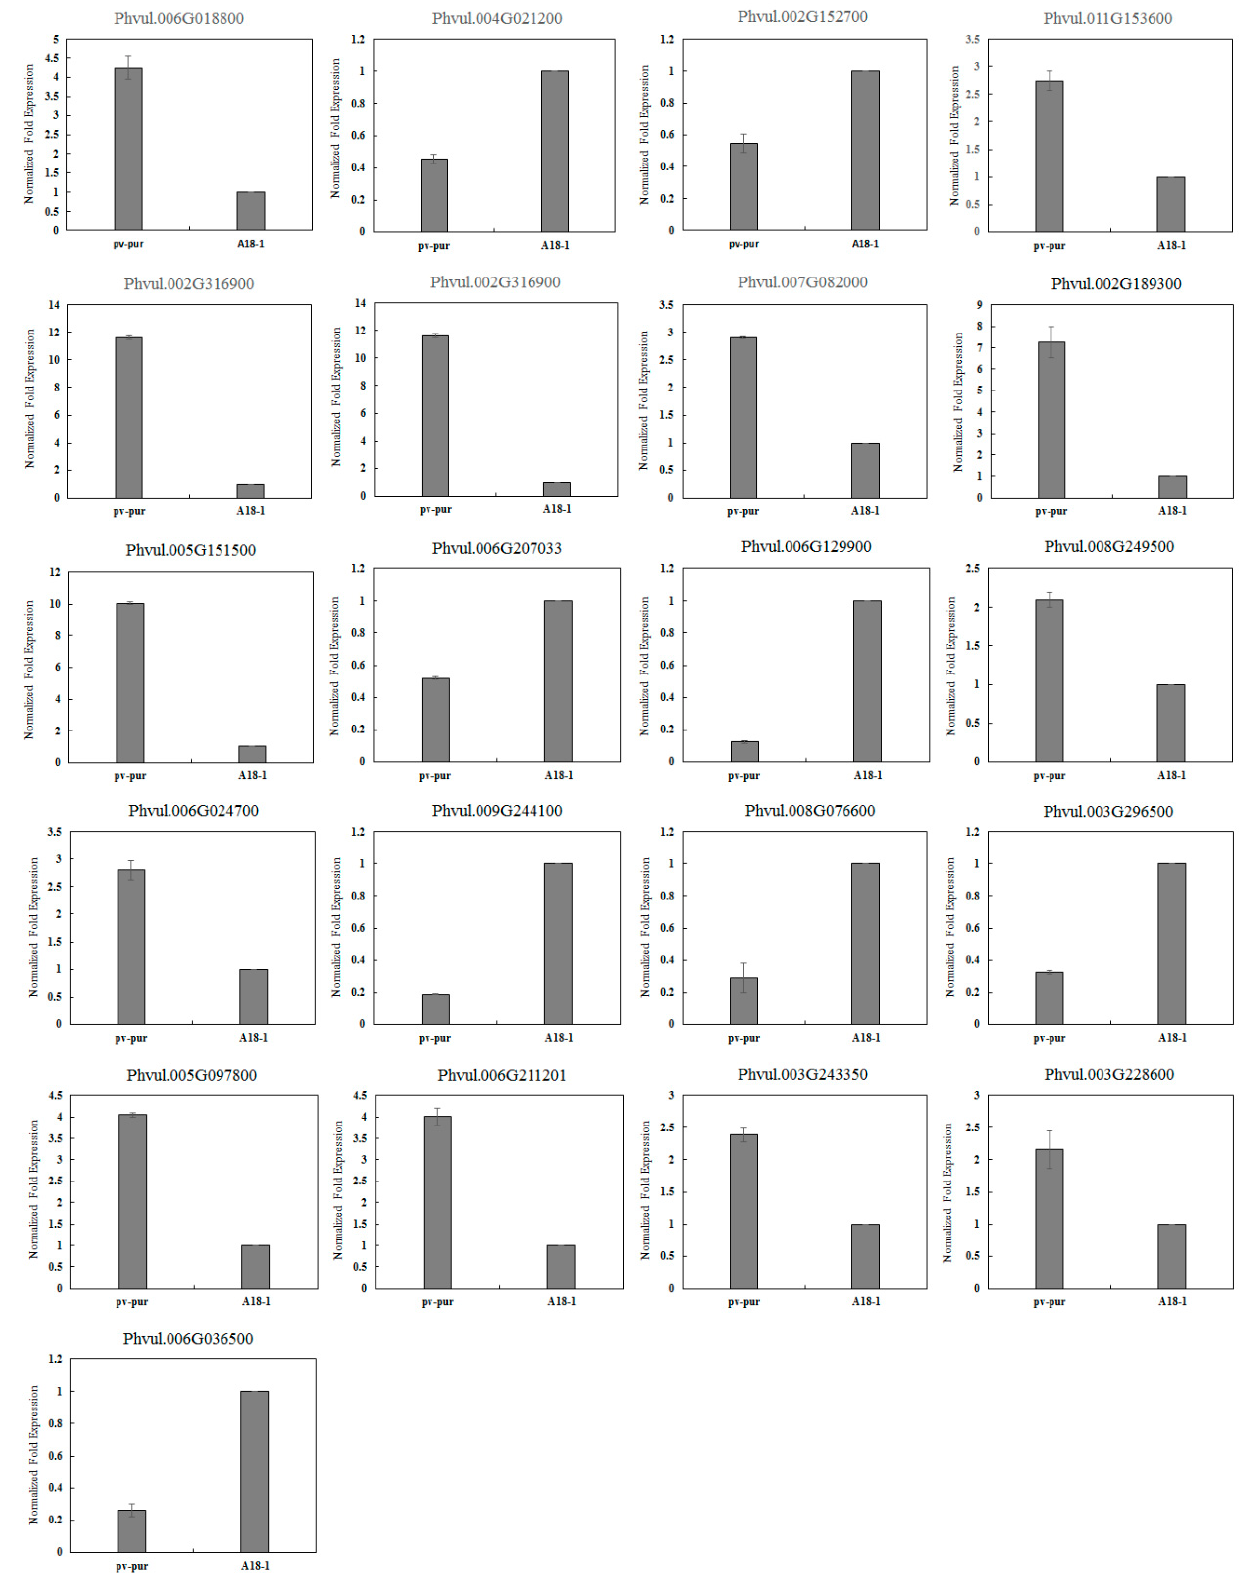
Figure 4. Validation of gene expression by qRT–PCR.